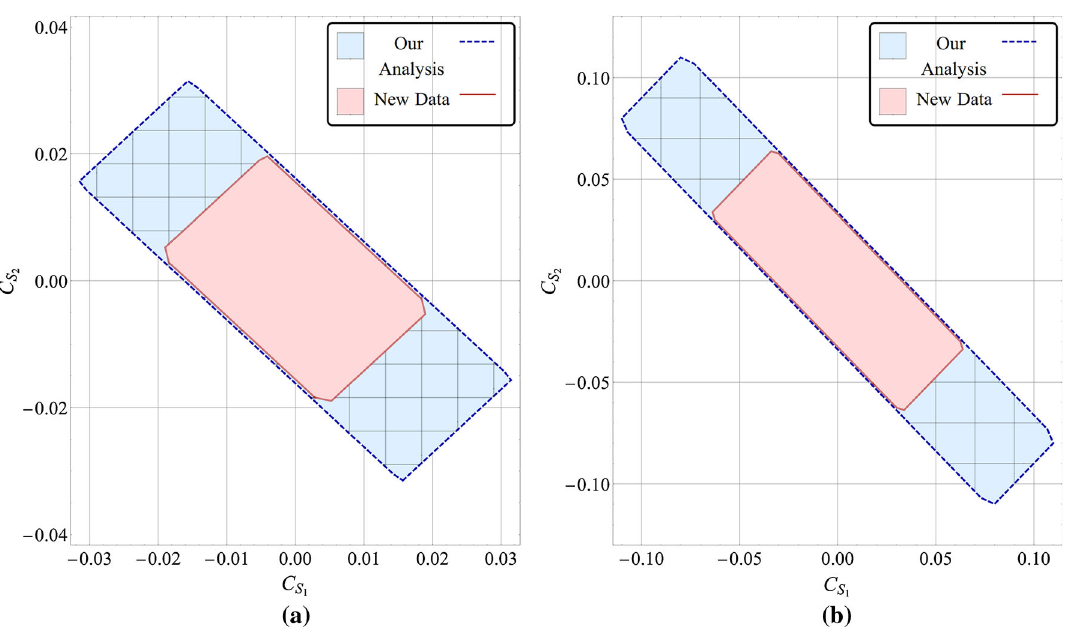
Fig. 2 Allowed ranges of C S the recent Belle data